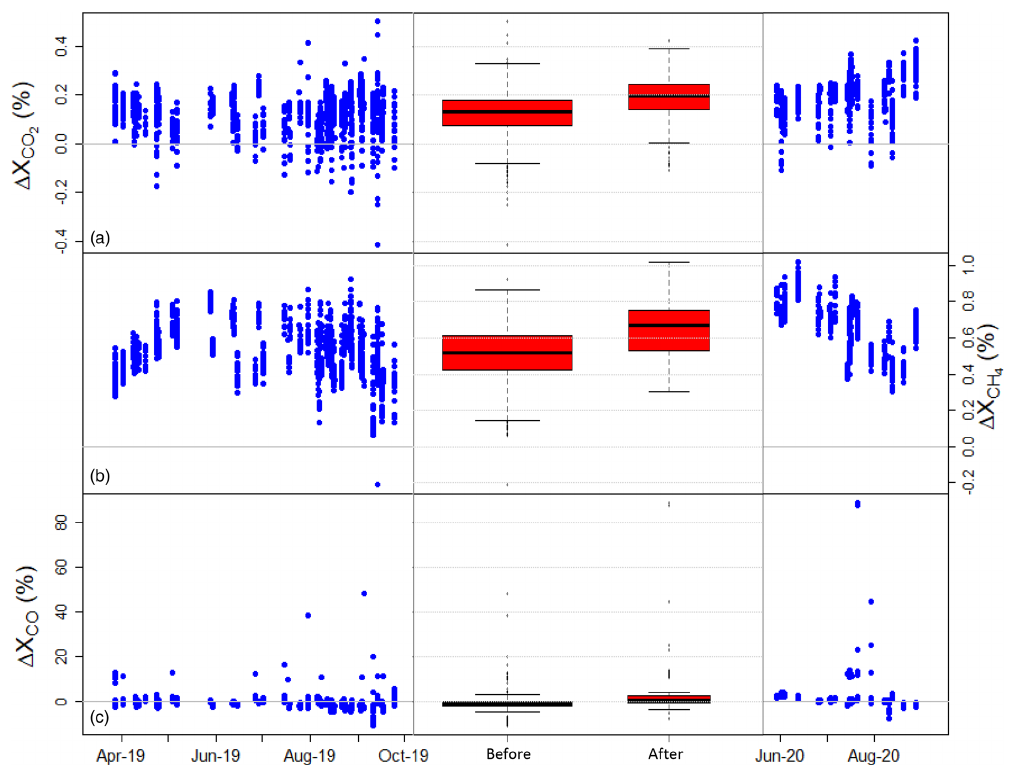
, (b) X CH and (c) X CO retrieved by the TCCON and 2 4